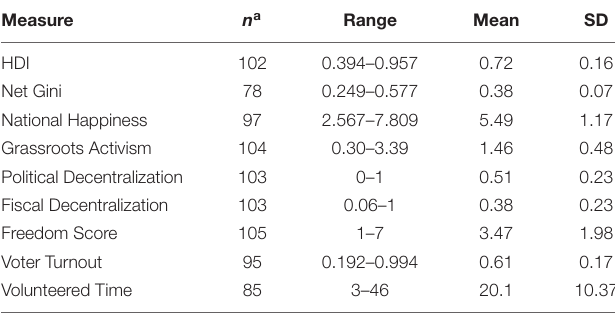
TABLE 1 | Descriptive statistics: HDI, Net GINI, national happiness, grassroots activism, political decentralization, fiscal decentralization, freedom score, voter turnout, and volunteered